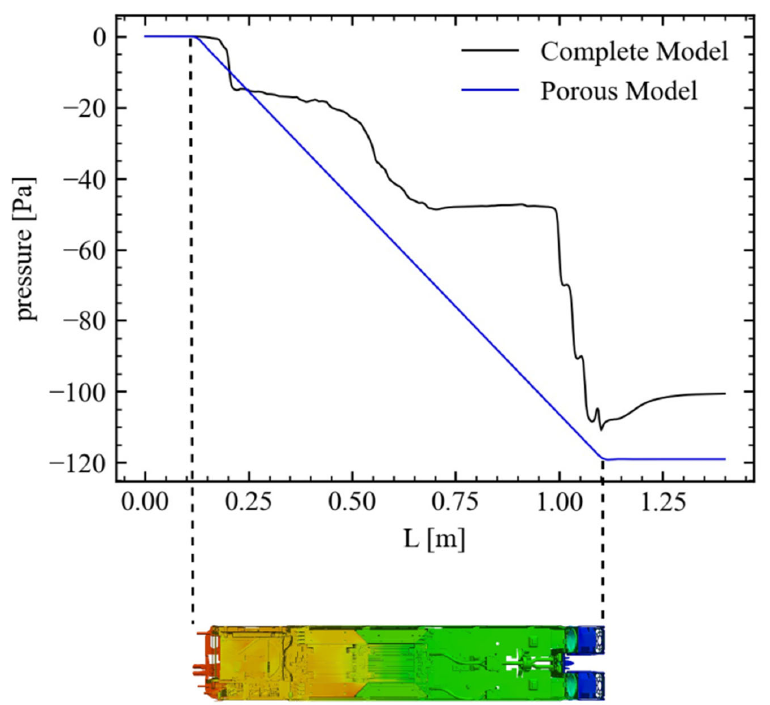
Figure 15. Comparison of the pressure distributions for the porous and complete models.